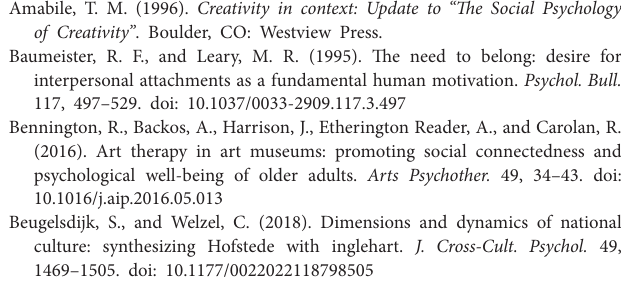
Path Values of individualism